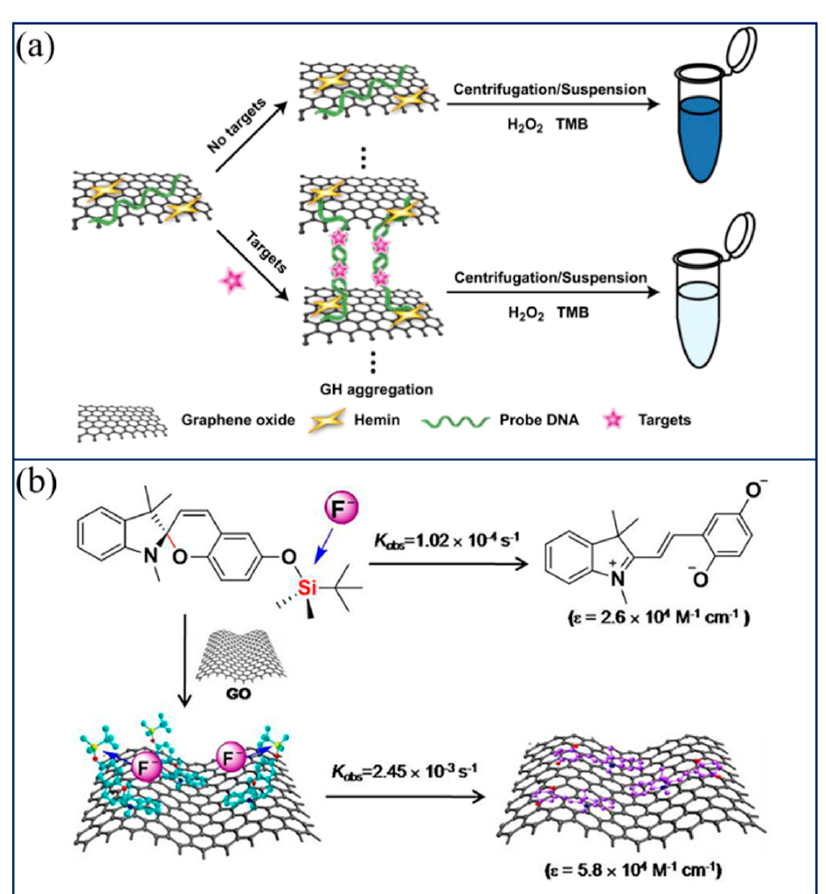
Figure 3. ( a ) Schematic illustration of procedures for Hg 2+ detection. Reprinted with permission from Ref. [61], Copyright 2013, Elsevier. ( b ) Determination of fluoride by functionalized graphene. Reprinted with permission from Ref. [62], Copyright 2013, American Chemical Society.